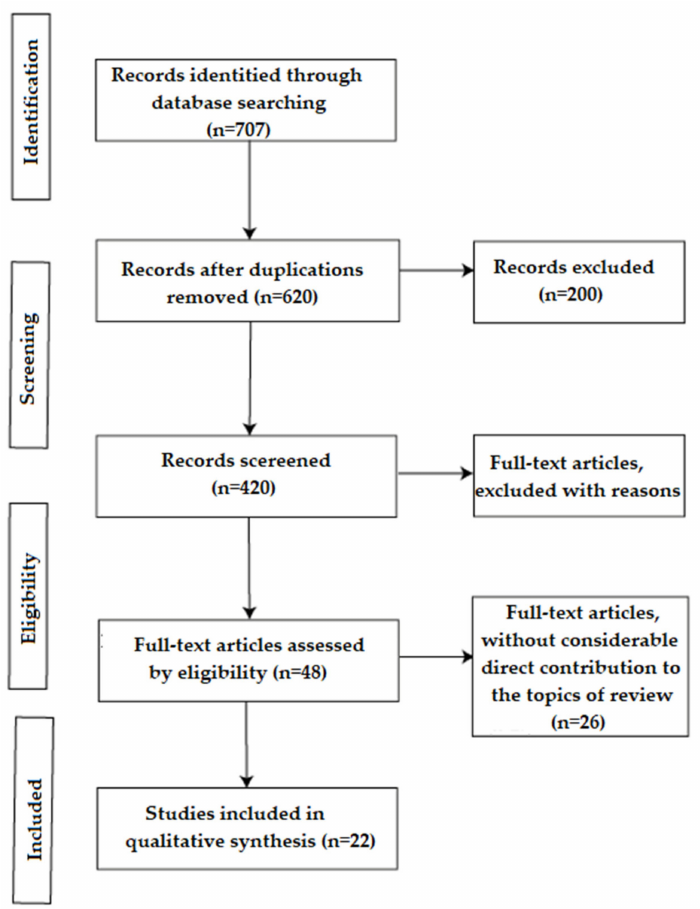
Figure 2. The PRISMA 2009 flow diagram of the search process for the highlighted and reviewed articles, according to Moher et al. Reproduced from Moher et al. [17], Springer 2009. (source: own research,